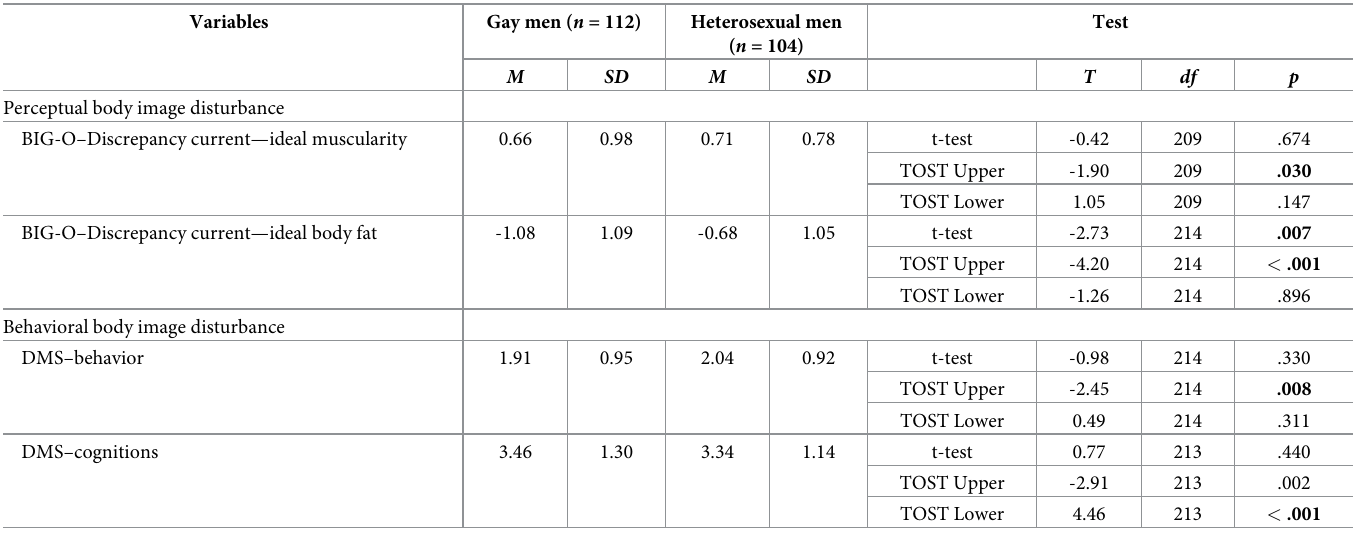
Table 3. Equivalence testing regarding perceptive body image disturbance and drive for muscularity. Variables